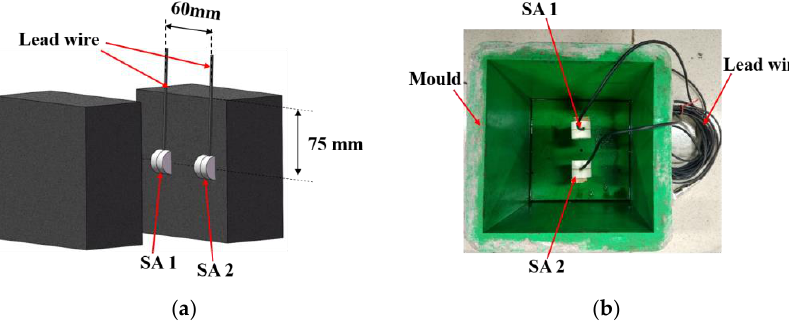
Figure 9. Configuration of SAs in concrete matrix. ( a ) Position of SAs in concrete cube, ( b ) Configuration of SAs in concrete test specimens before casting.